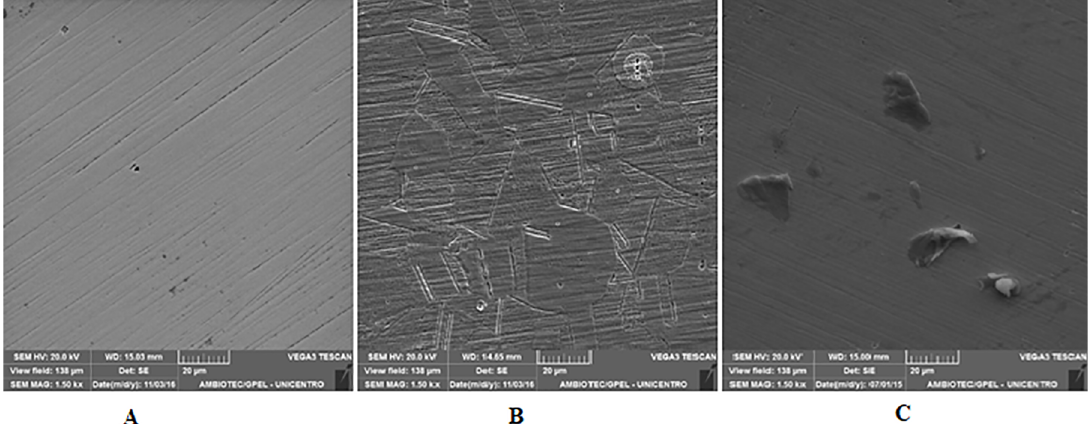
SO for 2 h; (C) after immersion 2 4